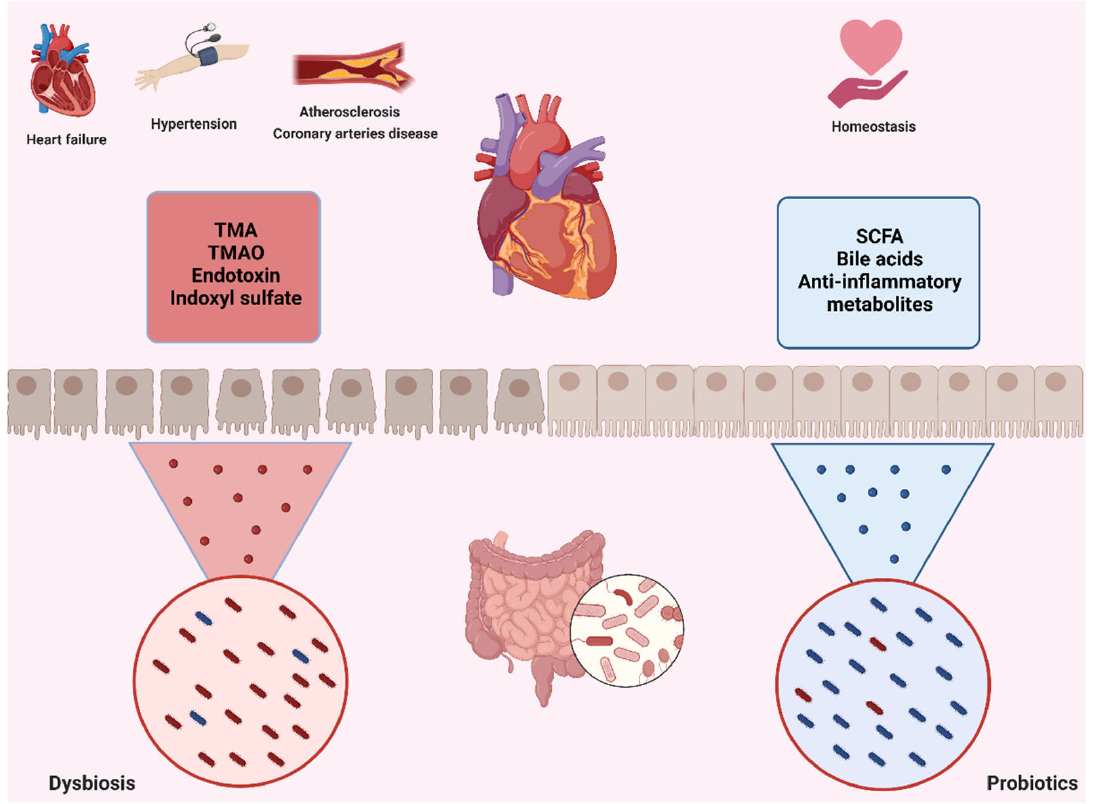
Figure 4. Microbiota–gut–heart axis. Through the gut microbiota and heart communication axis, ID may trigger or exacerbate heart diseases, such as hypertension, atherosclerosis, CAD, and even heart failure. In this case, ID favors the presence of bacteria that produce toxic metabolites, such as TMA, TMAO, indoxyl sulfate, and other endotoxins, which are responsible for the detrimental relationship between gut and heart. On the other hand, a balanced gut microbiota favors the production of SCFAs, bile acids, and other compounds that promote homeostatic processes in the heart: CAD, coronary artery disease; TMA, trimethylamine; TMAO, trimethylamine N-oxide; SCFAs, short-chain fatty acids. Created with Biorender.com.